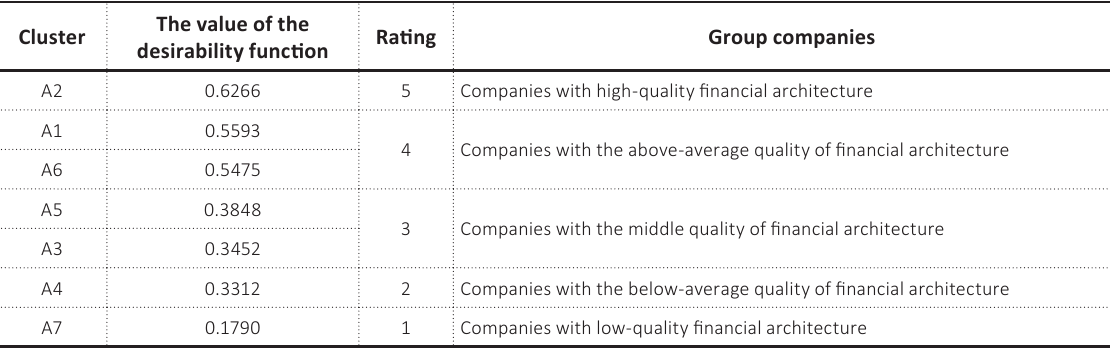
Table 3. Characteristics of companies based on cluster assessment